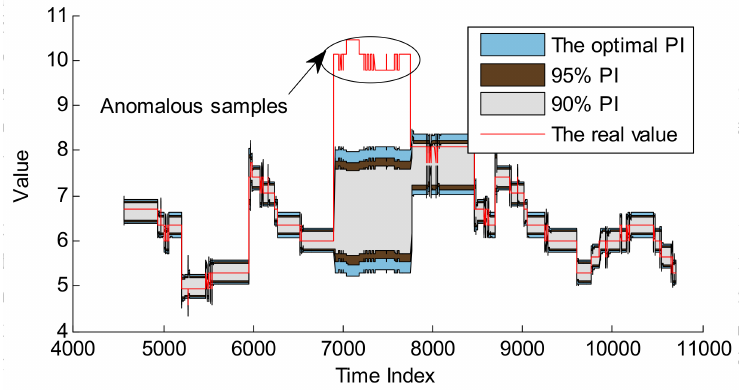
Figure 16. Anomaly detection for battery temperature series based on GPR model.